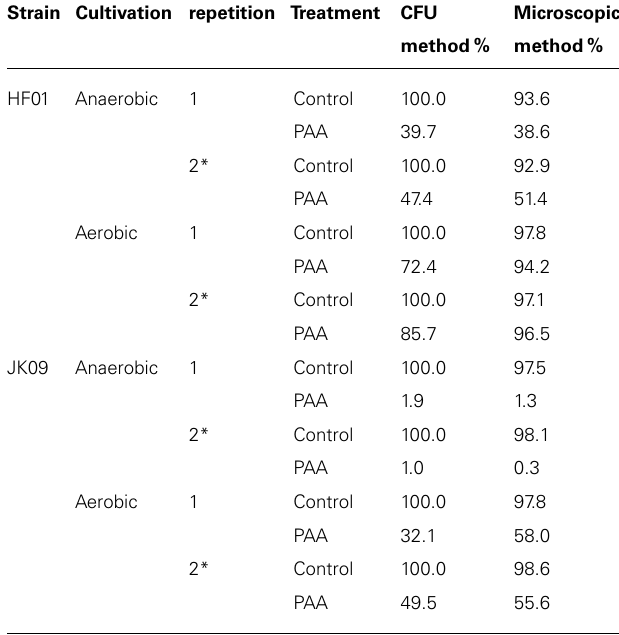
Table 2 | Comparison of survival rate measured by CFU and microscopic method. Strain Cultivation repetition Treatment